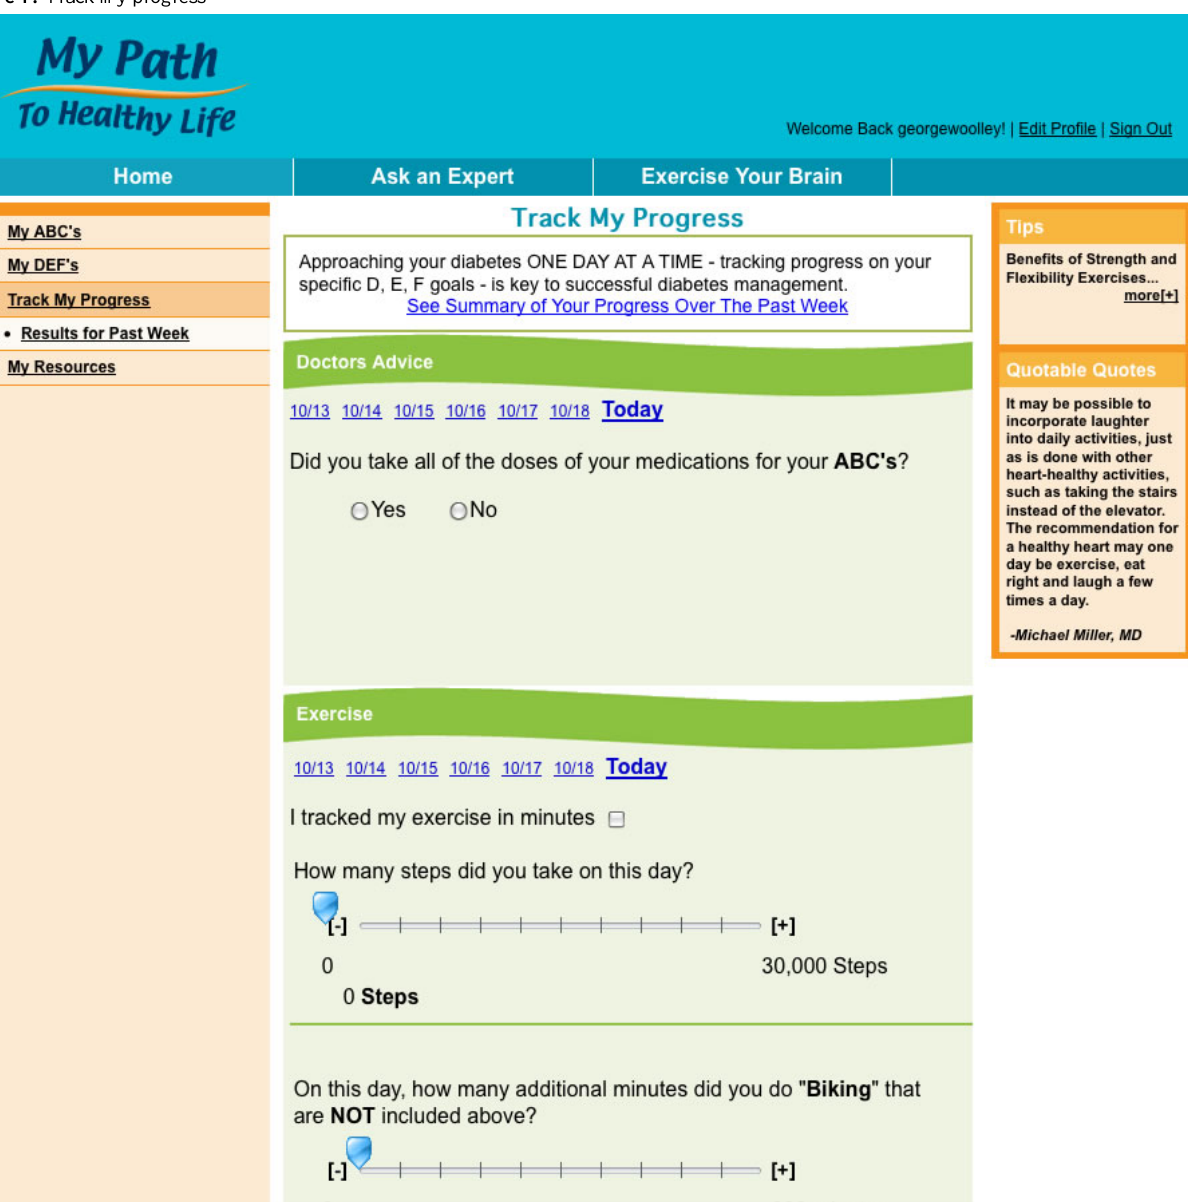
Figure 1. Track my